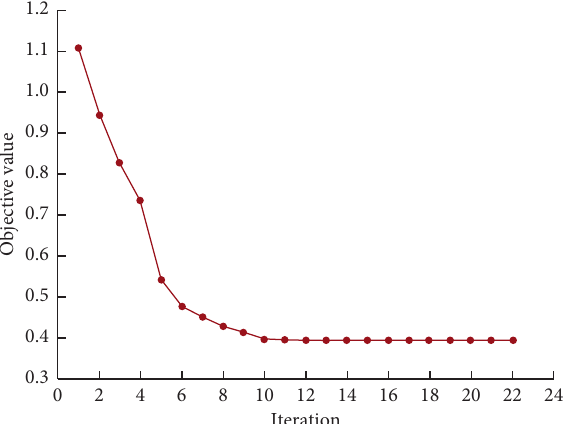
Figure 5: Variation tendency of the best objective value for instance I-240-13.